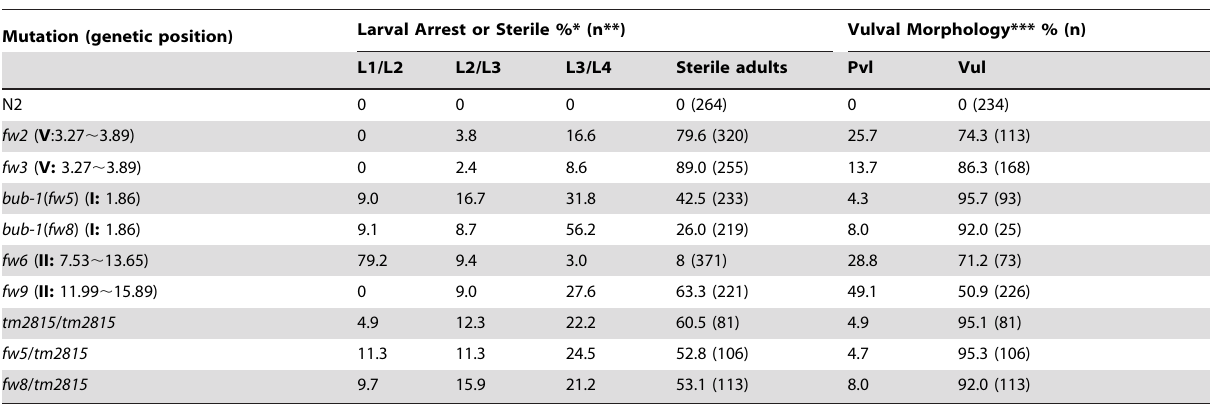
Table 1. Summary of the Developmental Phenotypes of Stu Mutants.